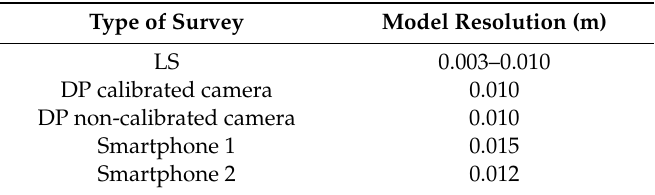
Table 3. Resolution of models using different survey methods.